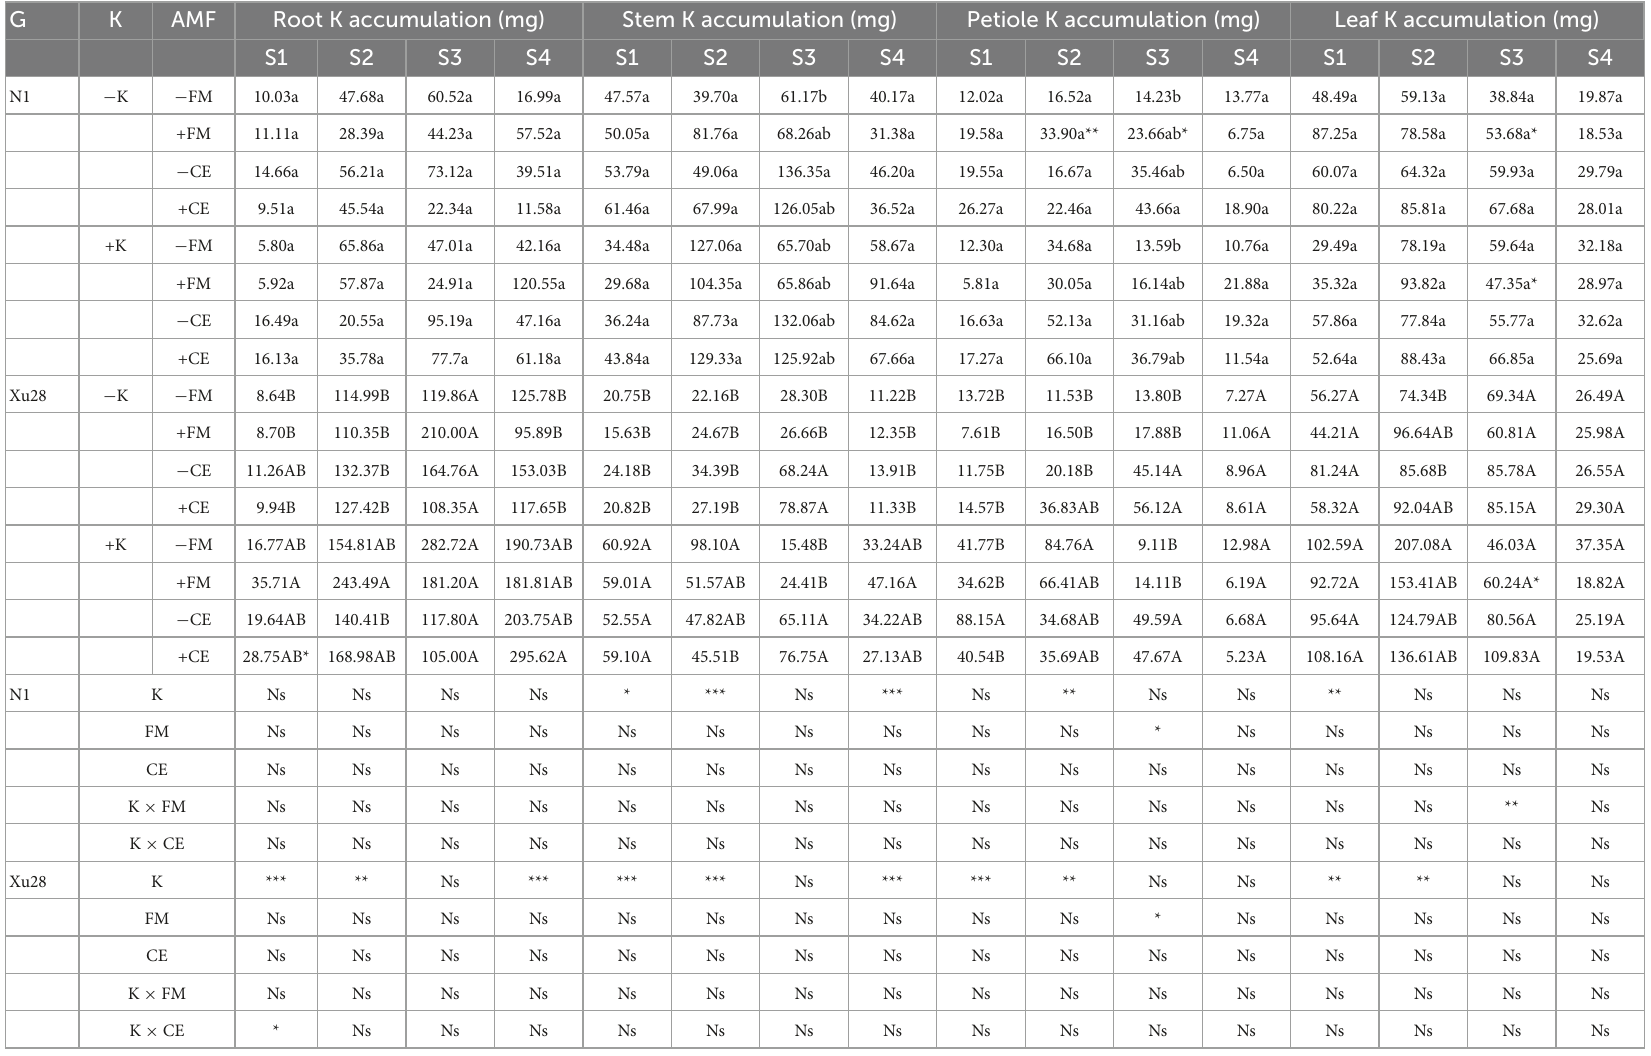
TABLE 1 The effects of K application and arbuscular mycorrhizal fungi (AMF) inoculation on K accumulation in different organs of sweet potato.